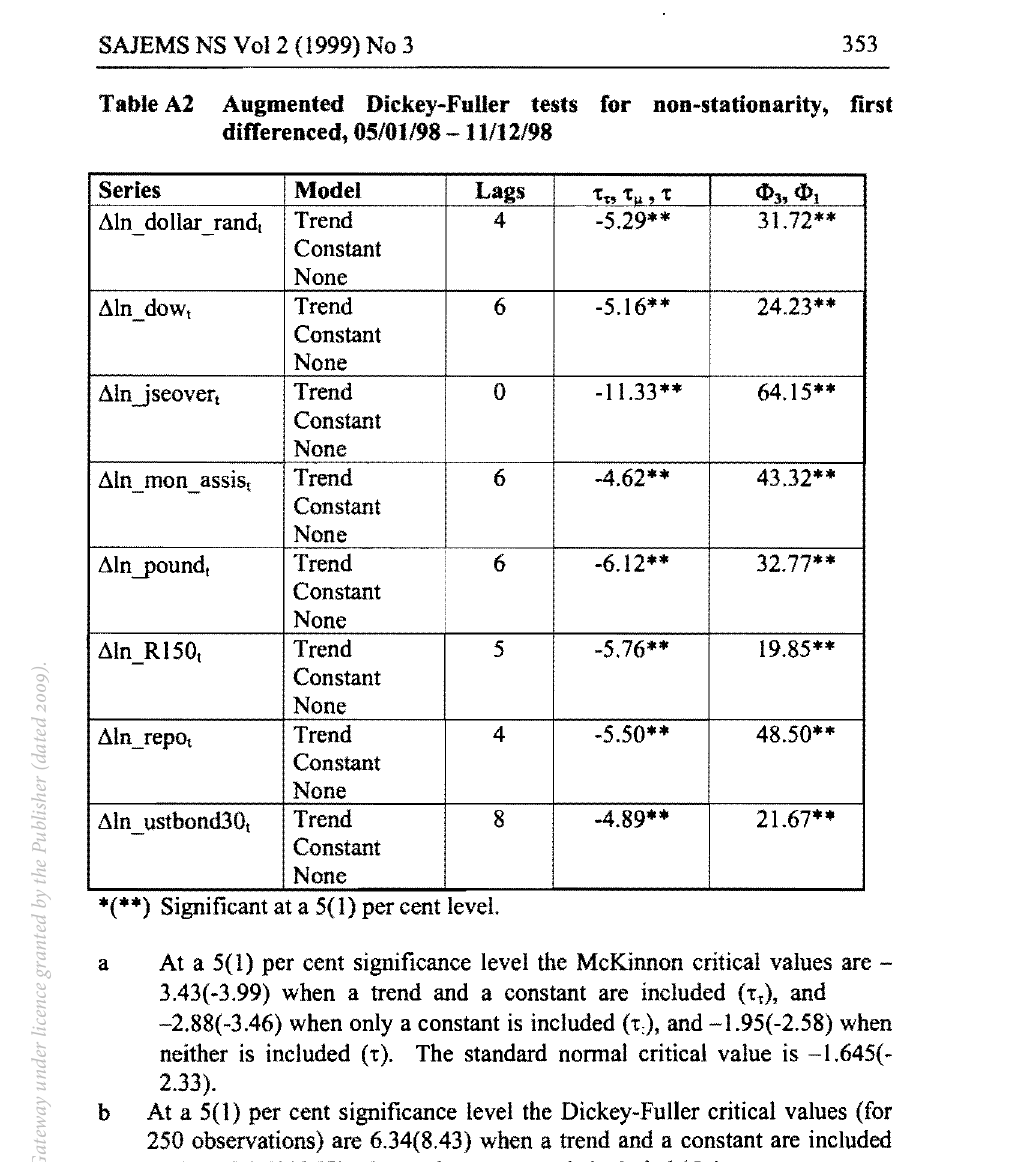
Augmented Dickey-Fuller tests for non-stationarity, first differenced, 05/01/98